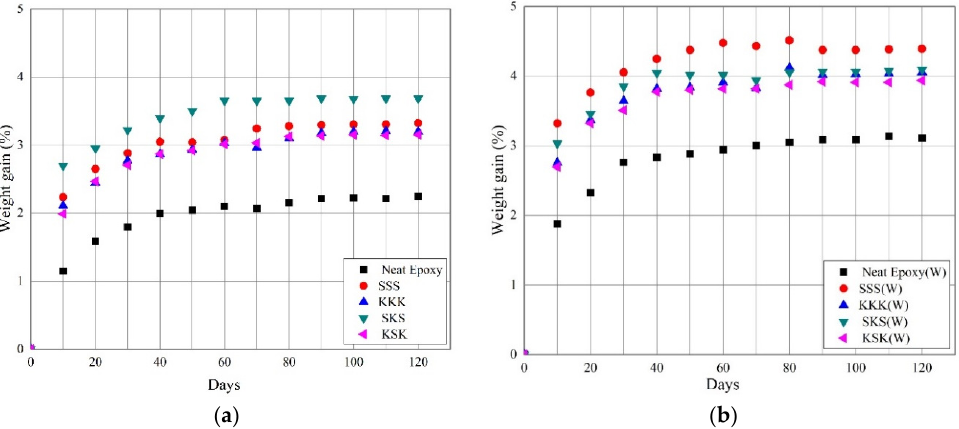
Figure 8. Water absorption behavior of the composites ( a ) before and ( b ) after weathering.